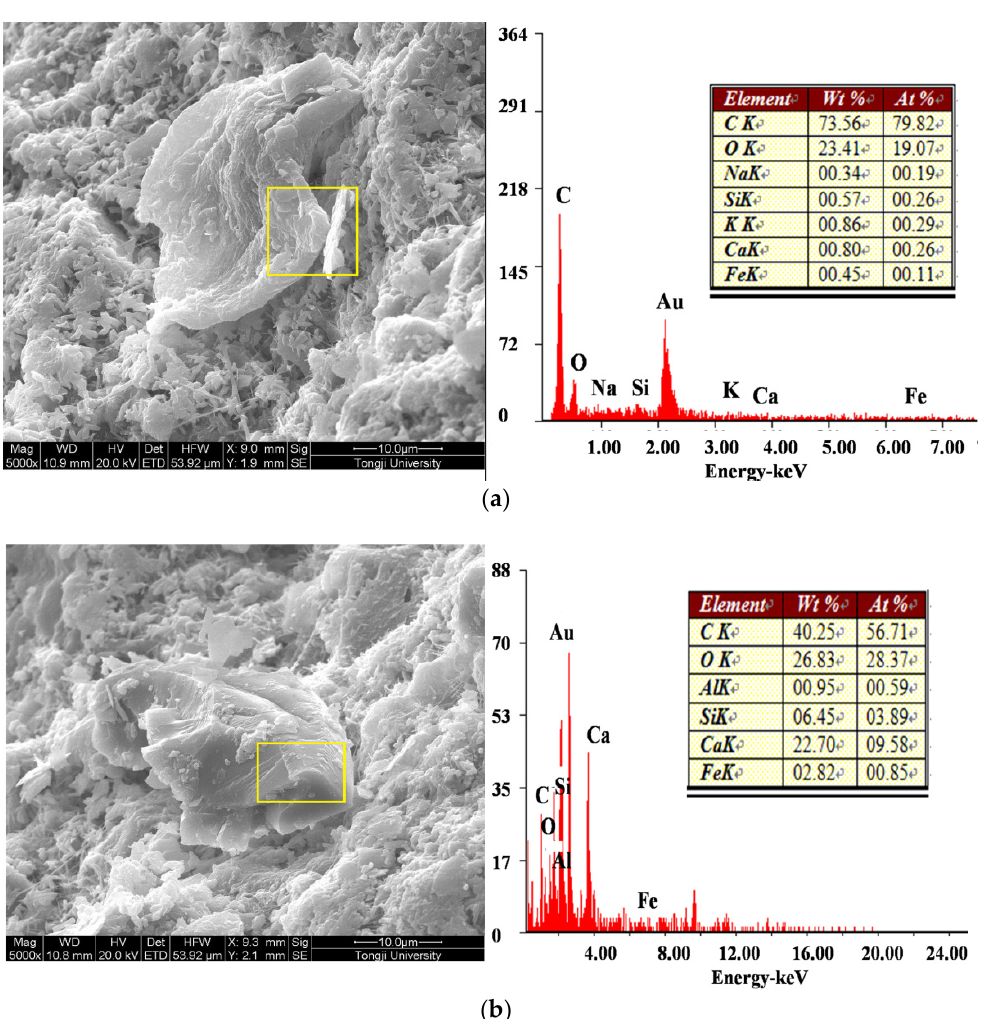
Figure 15. Residual microcapsule shell after outflow of healing agent: ( a ) core-wall ratio 1:1; ( b ) core-wall ratio 1:1.25.